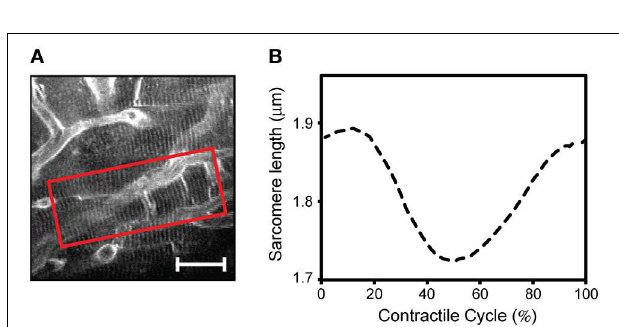
FIGURE 8 | Intravital two photon microscopy of cardiomyocyte function and structure in the beating heart. (A) Two-photon microscopy imaging reveals subcellular structures in individual cardiomyocytes in the contracting heart. Using prospective sequential segmented microscopy, motion-artifact-free images can be formed at every point in the cardiac cycle, enabling visualization of myocytes’ contractions. (B) Measurement of a single myocyte contractile cycle. The mean sarcomere length is calculated over the region of interest indicated in the red box in A, at every point in the cardiac cycle by Fourier transform analysis of the sarcomere striations. Adapted from Aguirre et al. (2014). (Scale bar; 20 µ